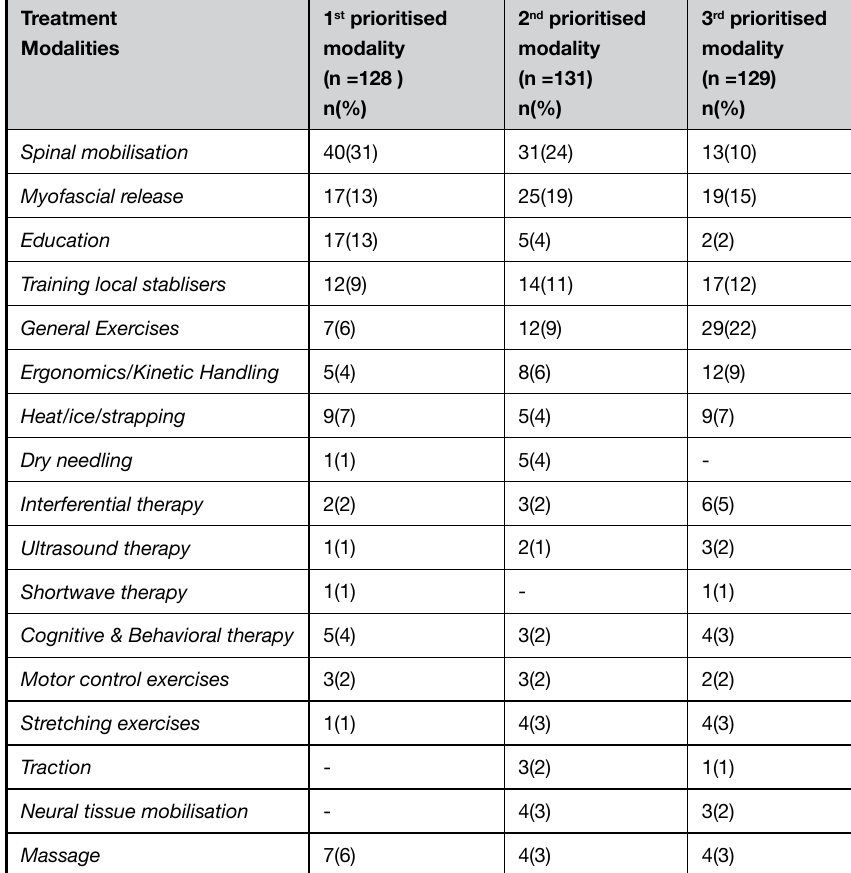
Table 1: Prioritised treatment modalities used in the management of